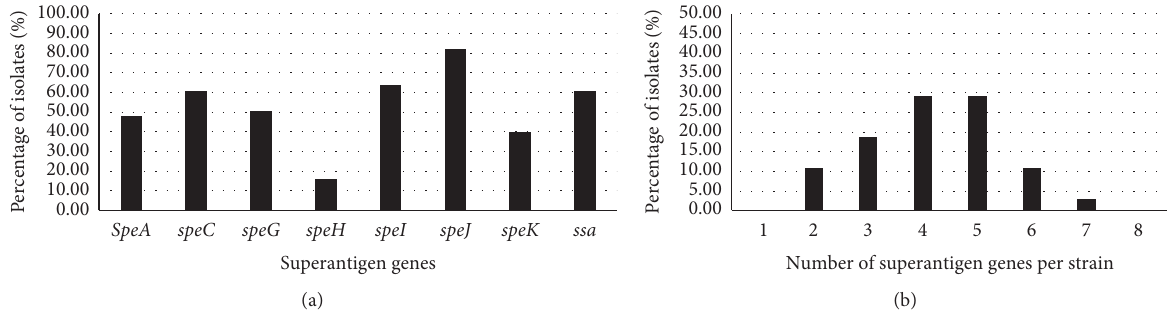
Figure 4: Prevalence of eight SAgs genes in 38 S. pyogenes isolates: (a) the occurrence of each SAgs gene in isolates and (b) the percentage of isolates containing different numbers from 1 to 8 SAgs